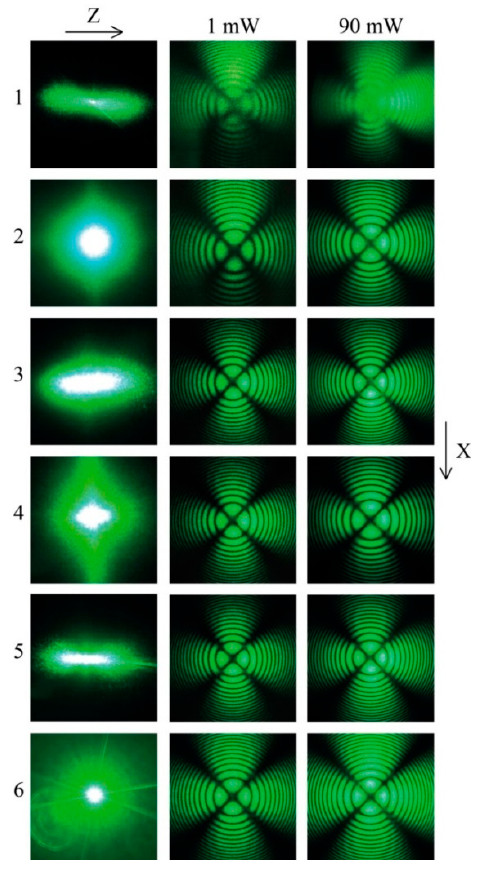
Figure 8. PILS speckle-structure ( p = 160 mW) after 60 s of irradiation and conoscopic patterns ( p = 1 and 90 mW) of SLN (1), CLN (2) and LiNbO 3 :B (0.55 (3), 0.69 (4), 0.83 (5), 1.24 (6) mol%). The figure is reproduced with the permission of Pleiades Publishing from the paper N. V. Sidorov et al., Techn. Phys. 2018 V. 63 P. 1758–1766, DOI: https://doi.org/10.1134/S1063784218120198 (accessed on 26 March 2021).